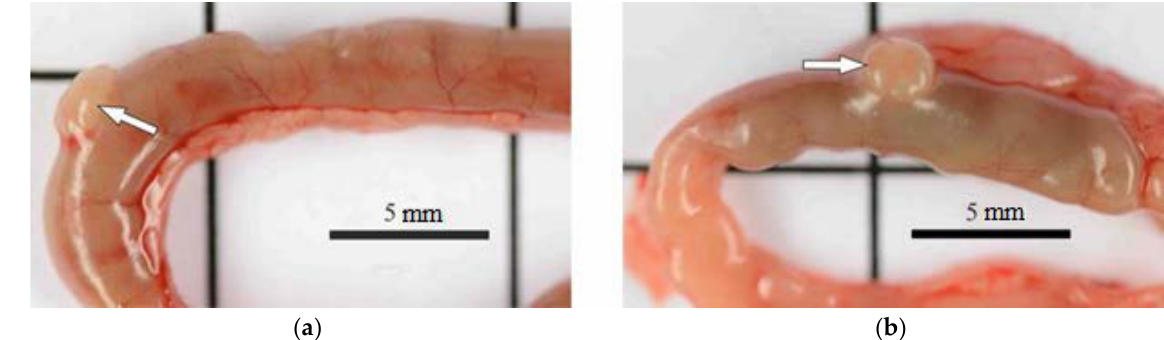
Figure 5. Jejunum area ( a ) control; ( b ) 2.25 mg/kg dose of AgNPs-BAC. Peyer’s patches are indicated by arrows: normal ( a ) and enlarged ( b ).